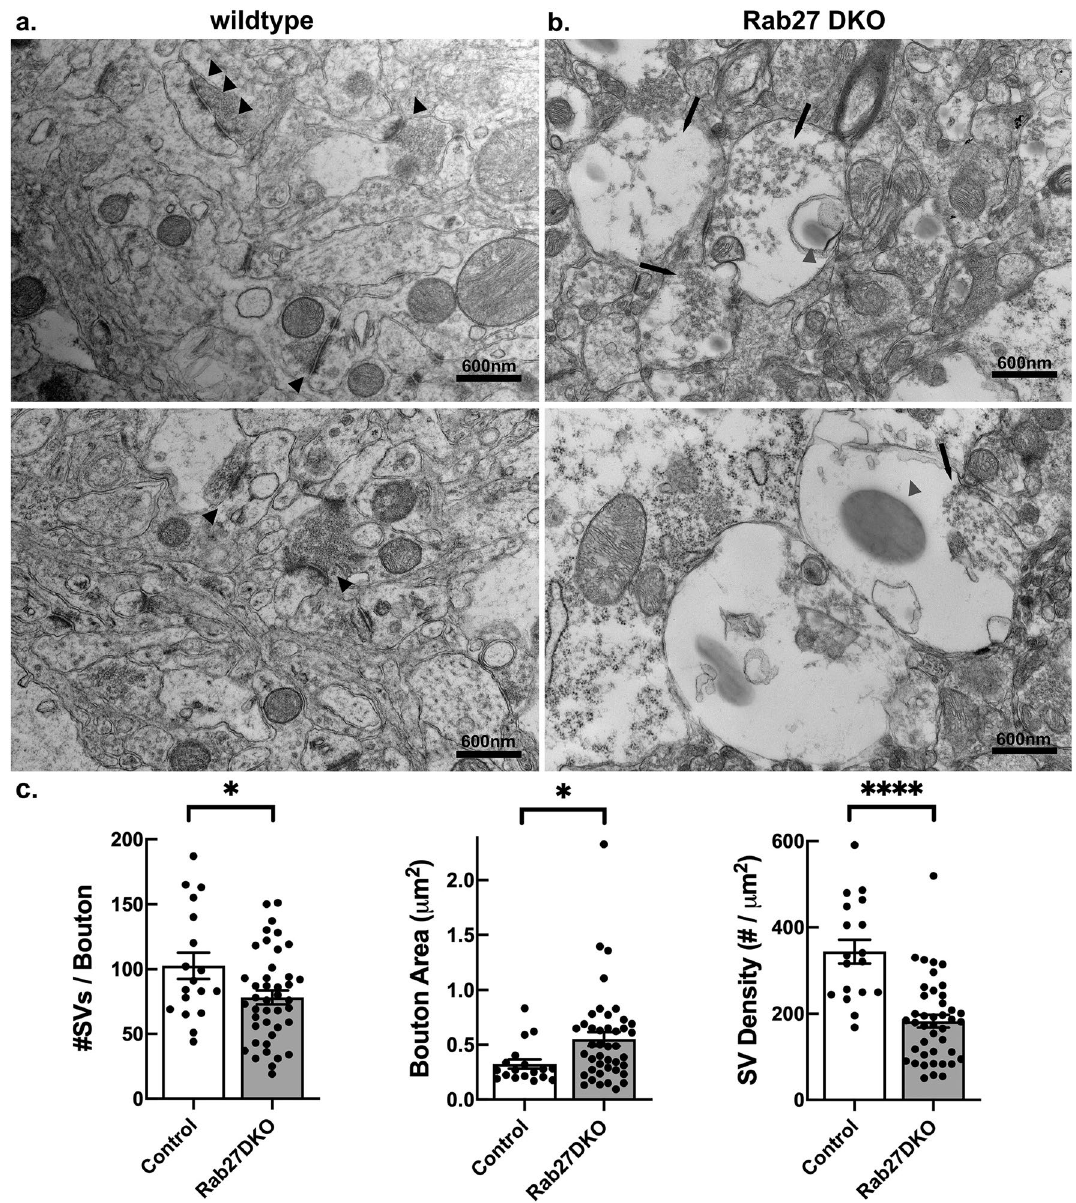
arrowheads point to synaptic terminals. ( b ) Representative transmission EM images of motor cortex from a Rab27 DKO mouse with the chromosome 6 deletion involving Snca and Mmrn1 . Scale bar = 600 nm. Black arrows point to abnormal synaptic terminals. Gray arrowheads point to membrane-less structures not observed in wildtype mice. ( c ) Quantification of synaptic vesicle number, bouton area, and synaptic vesicle density in motor cortices from wildtype C57BL/6J and Rab27 DKO mice with the chromosome 6 deletion involving Snca and Mmrn1 . n = 18 synapses for control and 42 synapses for Rab27 DKO. *p < 0.05, ****p < 0.0001 (unpaired, two-tailed t